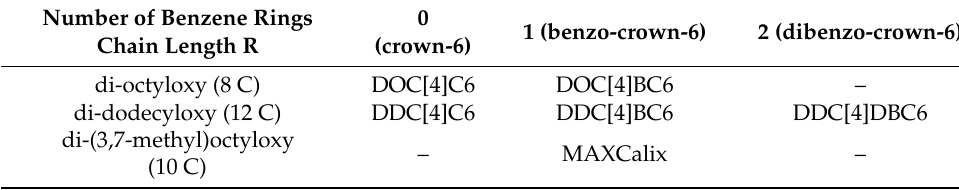
Figure 1. BOBCalix ( left ) and mono-crown-ether compounds representation ( right ): blue, dibenzo crown; light brown, benzo crown. Table 1. Calixarene mono-crown-ethers corresponding to Figure 1 (right).